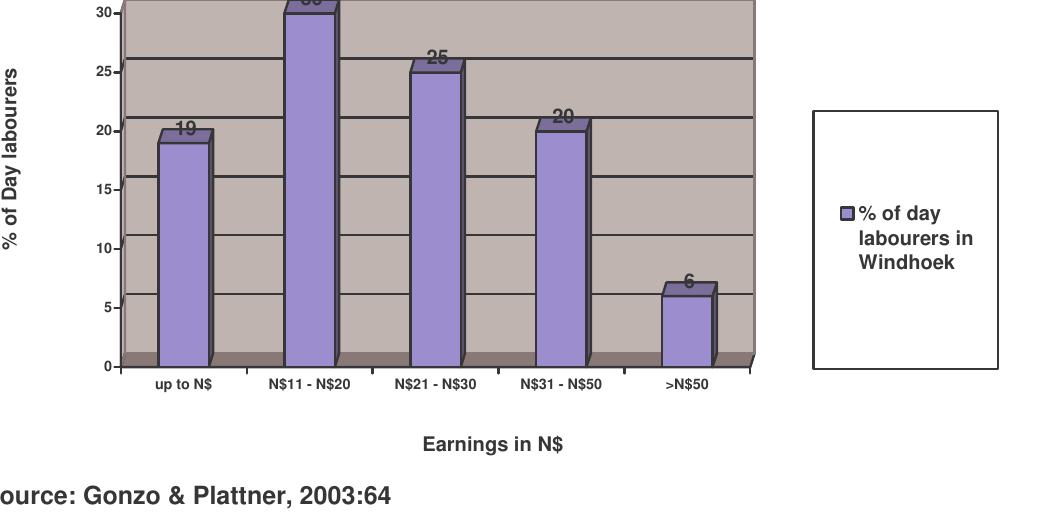
Figure 5: Payment received for a job among day labourers in Windhoek